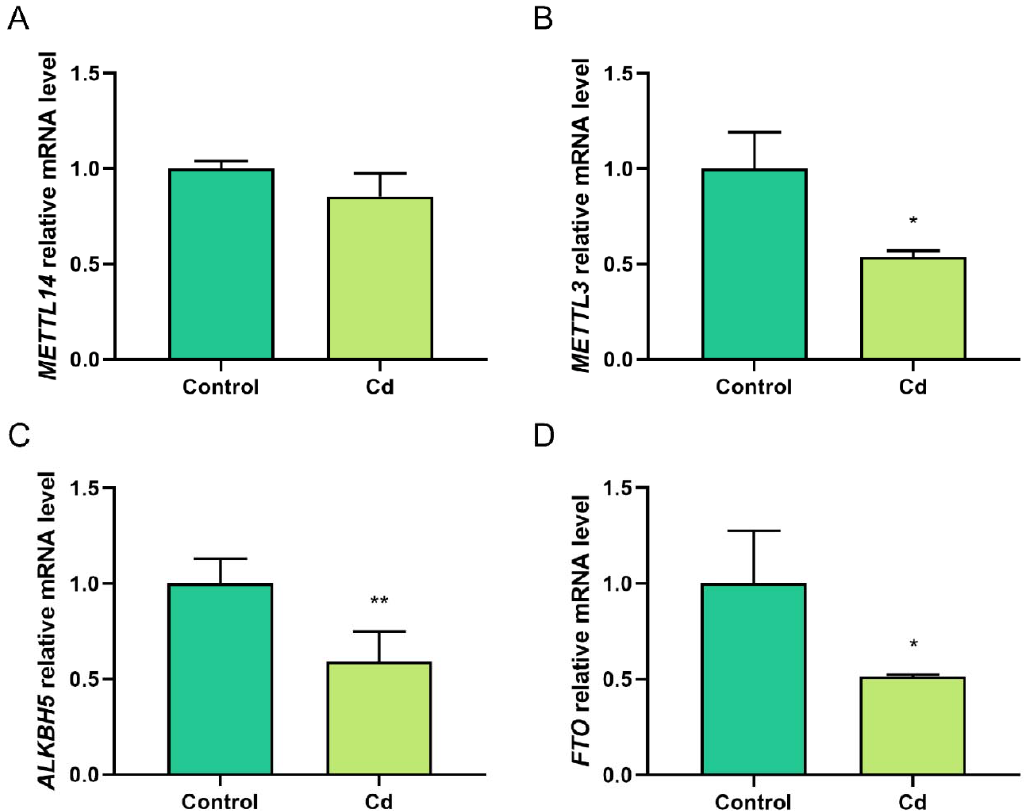
Figure 3. Expression of m 6 A methylation-regulated genes in Cd-treated granulosa cells. ( A – D ) RT- qPCR results revealed transcript levels of METTL14. METTL3 , ALKBH5 , and FTO after Cd treatment. * p < 0.05; ** p <